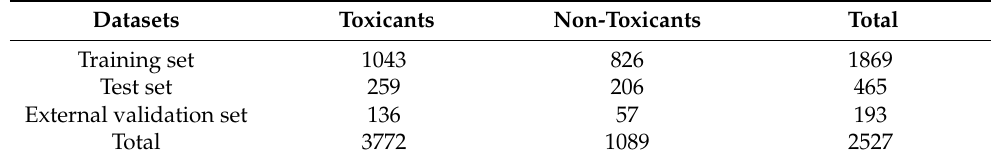
Table 1. The number of compounds associated with respiratory toxicity in the modeling